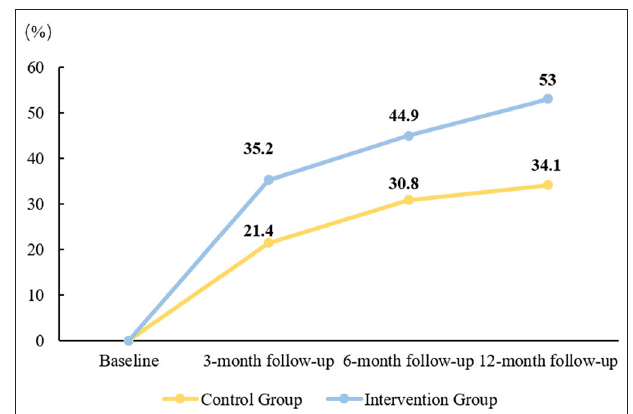
FIGURE 2 | The proportion of patients in maintenance